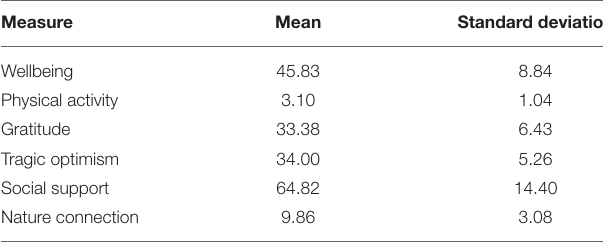
TABLE 2 | Mean and Standard Deviation of